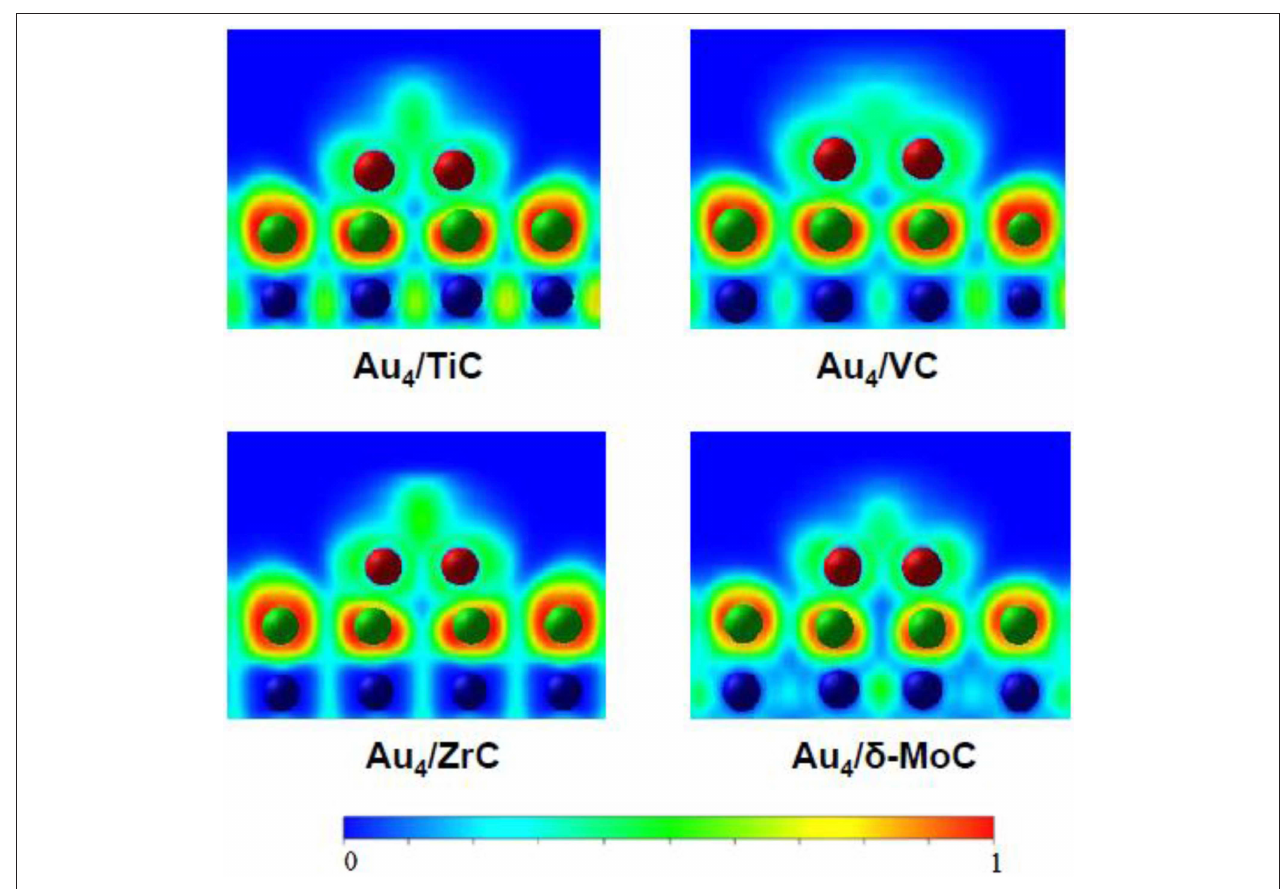
FIGURE 3 | Calculated electron densities for a Au 4 cluster on different carbide substrates. Reproduced with permission from Florez et al. (2009), copyright 2009 by the American Chemical Society.